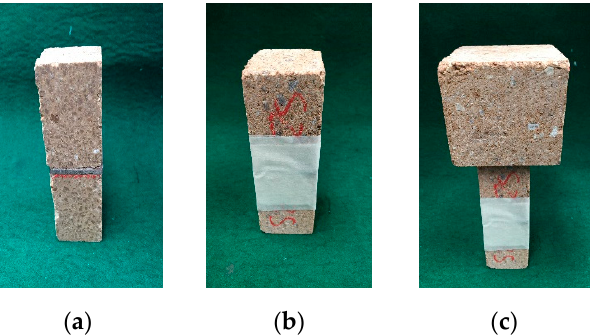
Figure 2. Assemblage for sandwich coating test used in the present work. ( a ) Calcined meal cylinder between portions of brick sample. ( b ) Sandwich sample wrapped with a tape. ( c ) Placement of 5.3 kPa load.